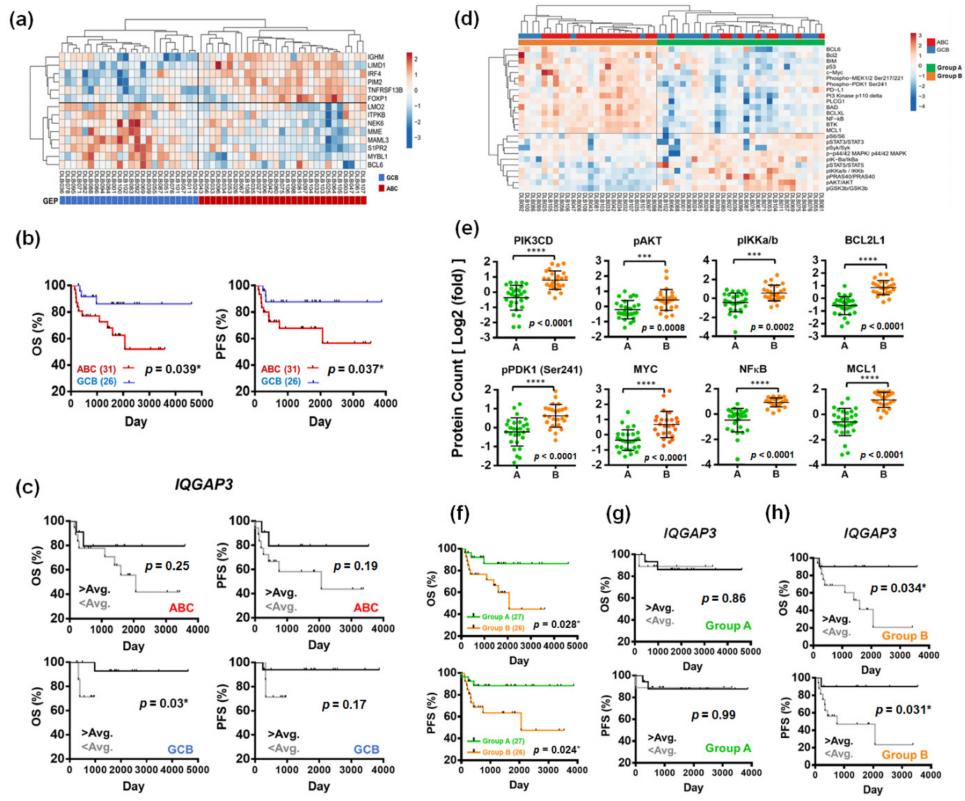
Figure 5. Proteomics-based re-categorization prognosticates DLBCL patients and reinforces the clinical significance of